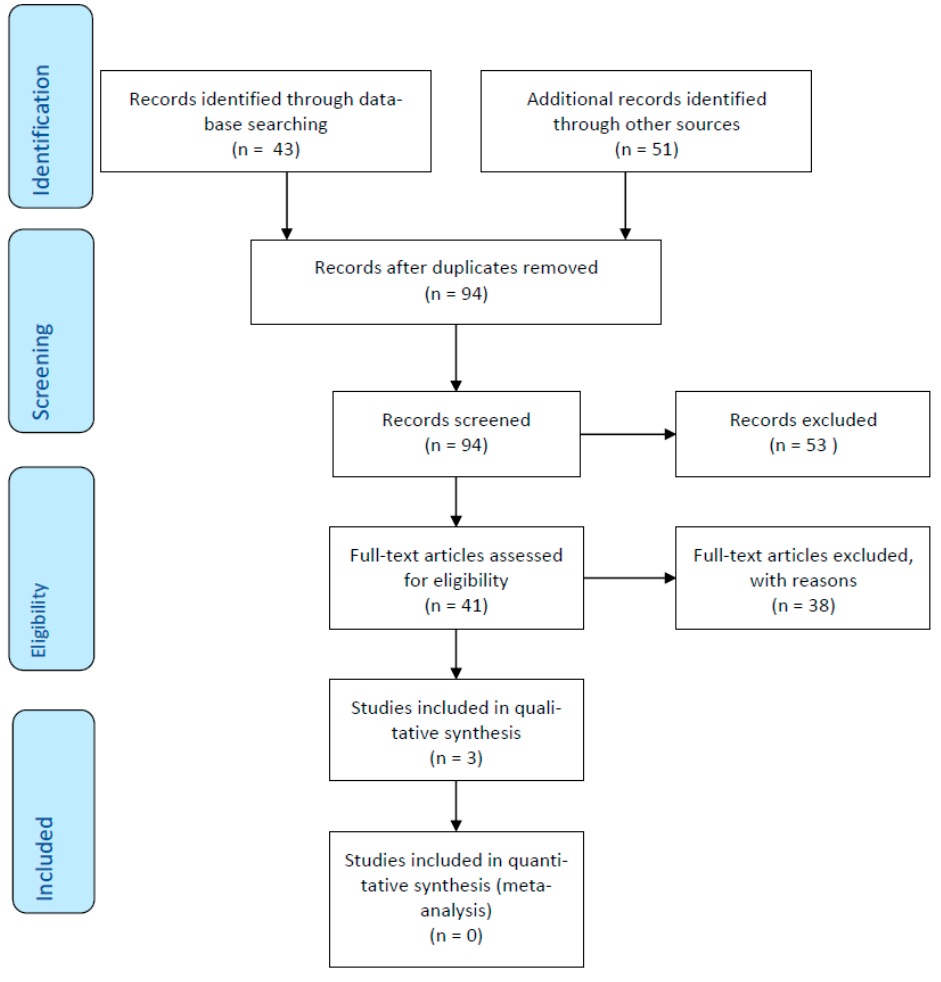
Figure 1. PRISMA Flow Chart.